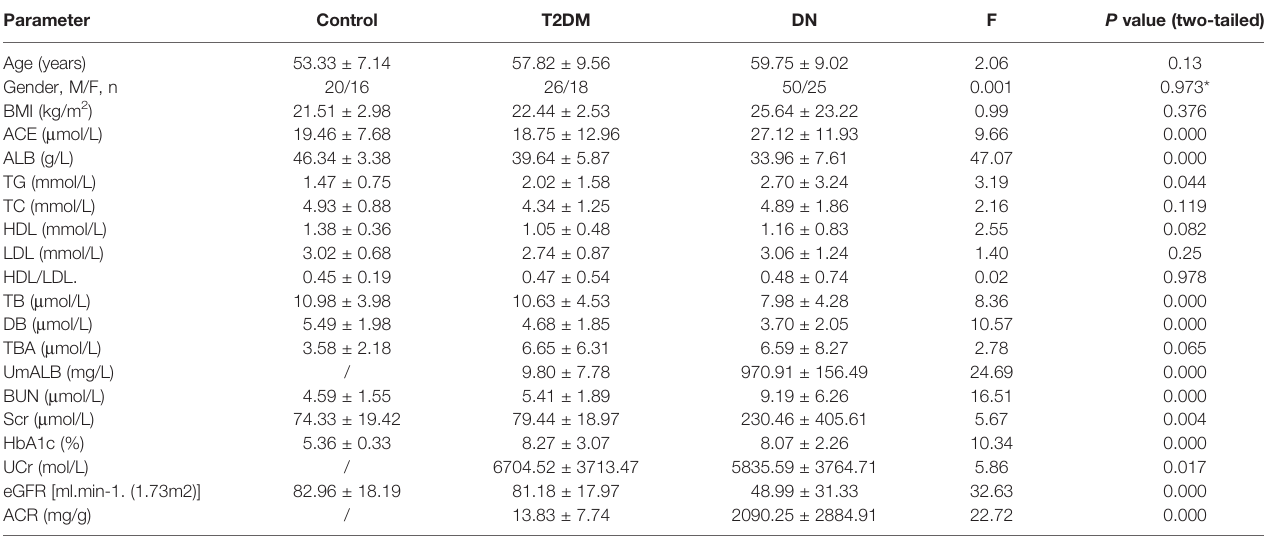
TABLE 1 | Characteristics of the subjects included in this study (mean ±